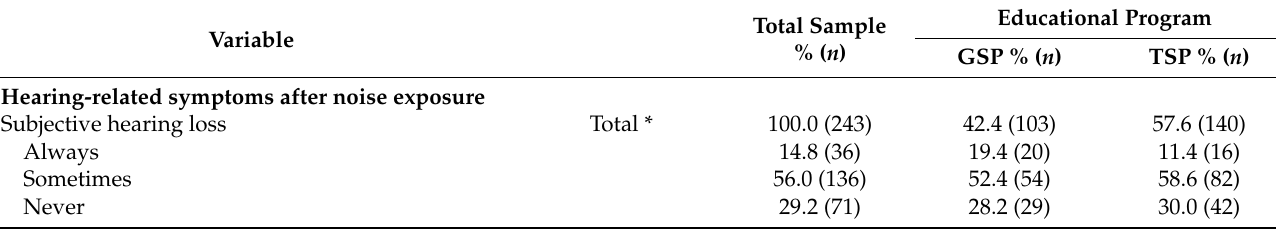
Table 1. Overview of hearing-related symptoms and speech understanding difficulties for the total sample as well as distributed for the students from the general secondary program (GSP) and technical secondary program